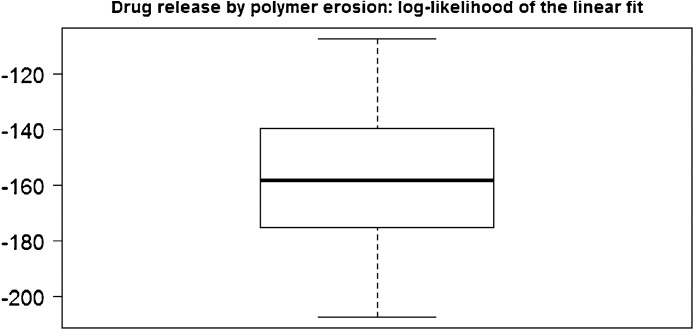
Distribution of the log-likelihood of the linear fit for N(t) given in Eq. (5), obtained in 50 simulation runs.